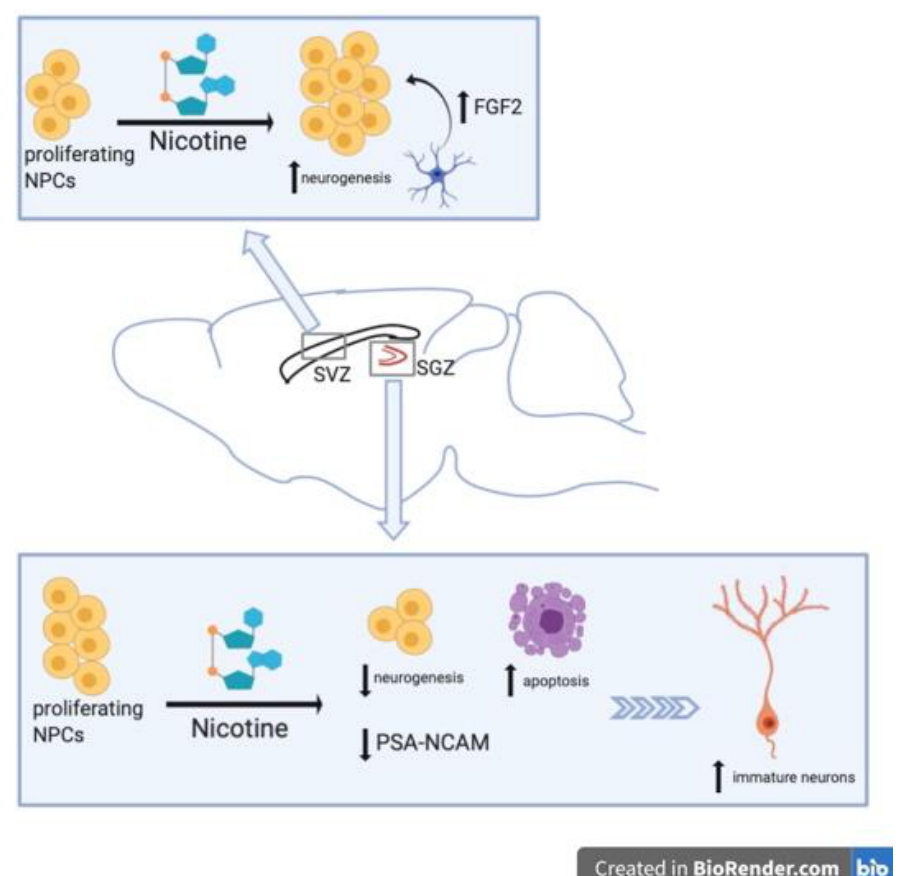
Figure 1. Graphical summary of nicotine’s effects on NSC proliferation. Nicotine exhibits region- specific effects on neurogenesis. In the subventricular zone (SVZ), nicotine exposure enhances neurogenesis while in the SGZ it decreases neurogenesis.